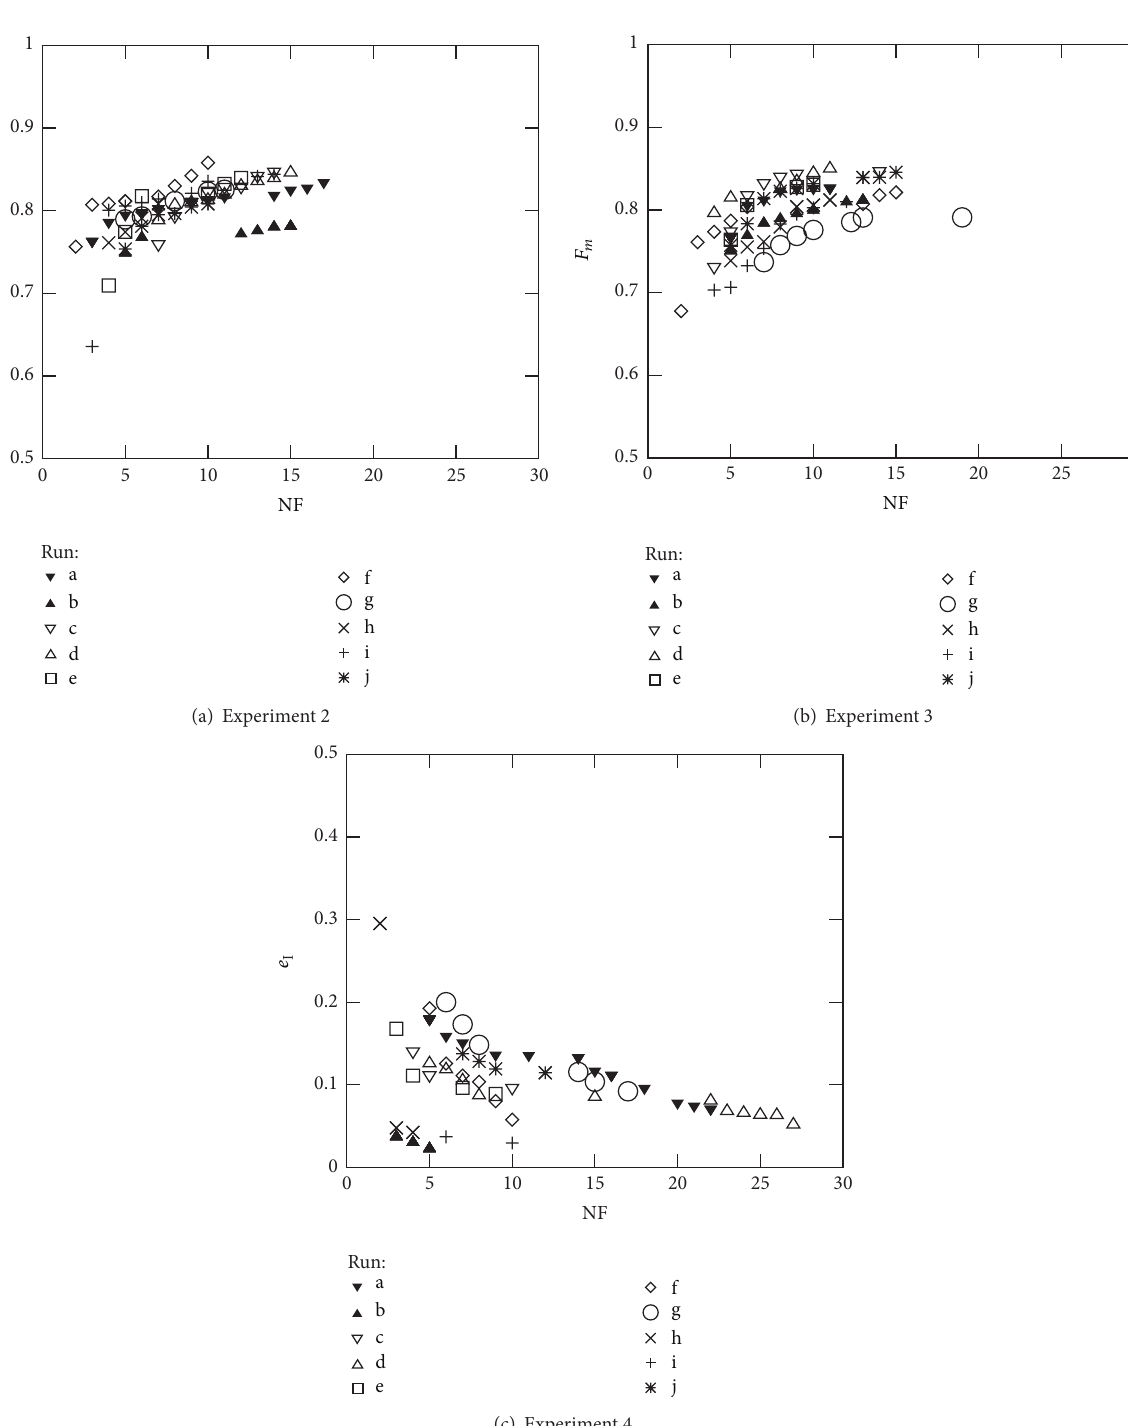
Figure 5: Optimal Pareto fronts for Diane 2005 data (10